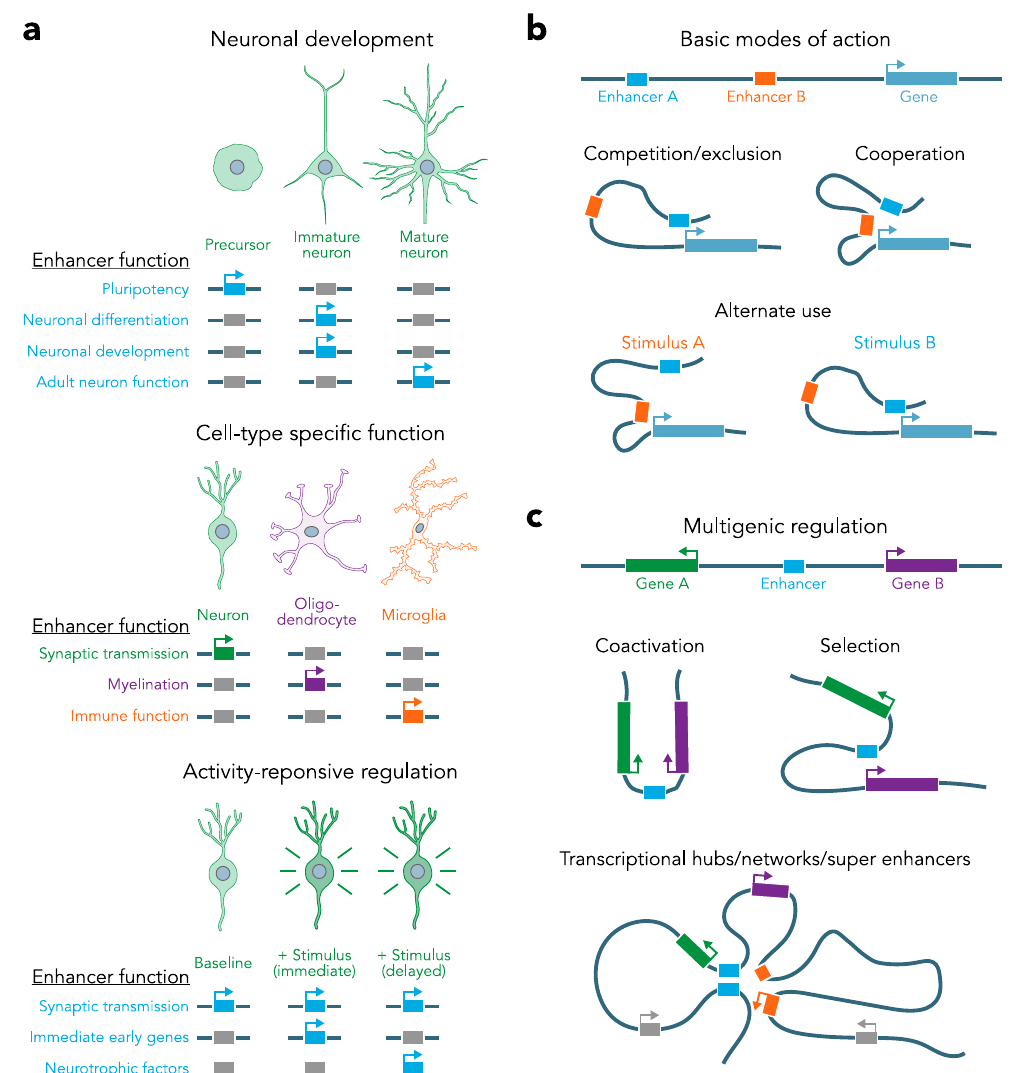
Figure 2. Developmental, cell-type specific, and stimulus dependent enhancer activity and